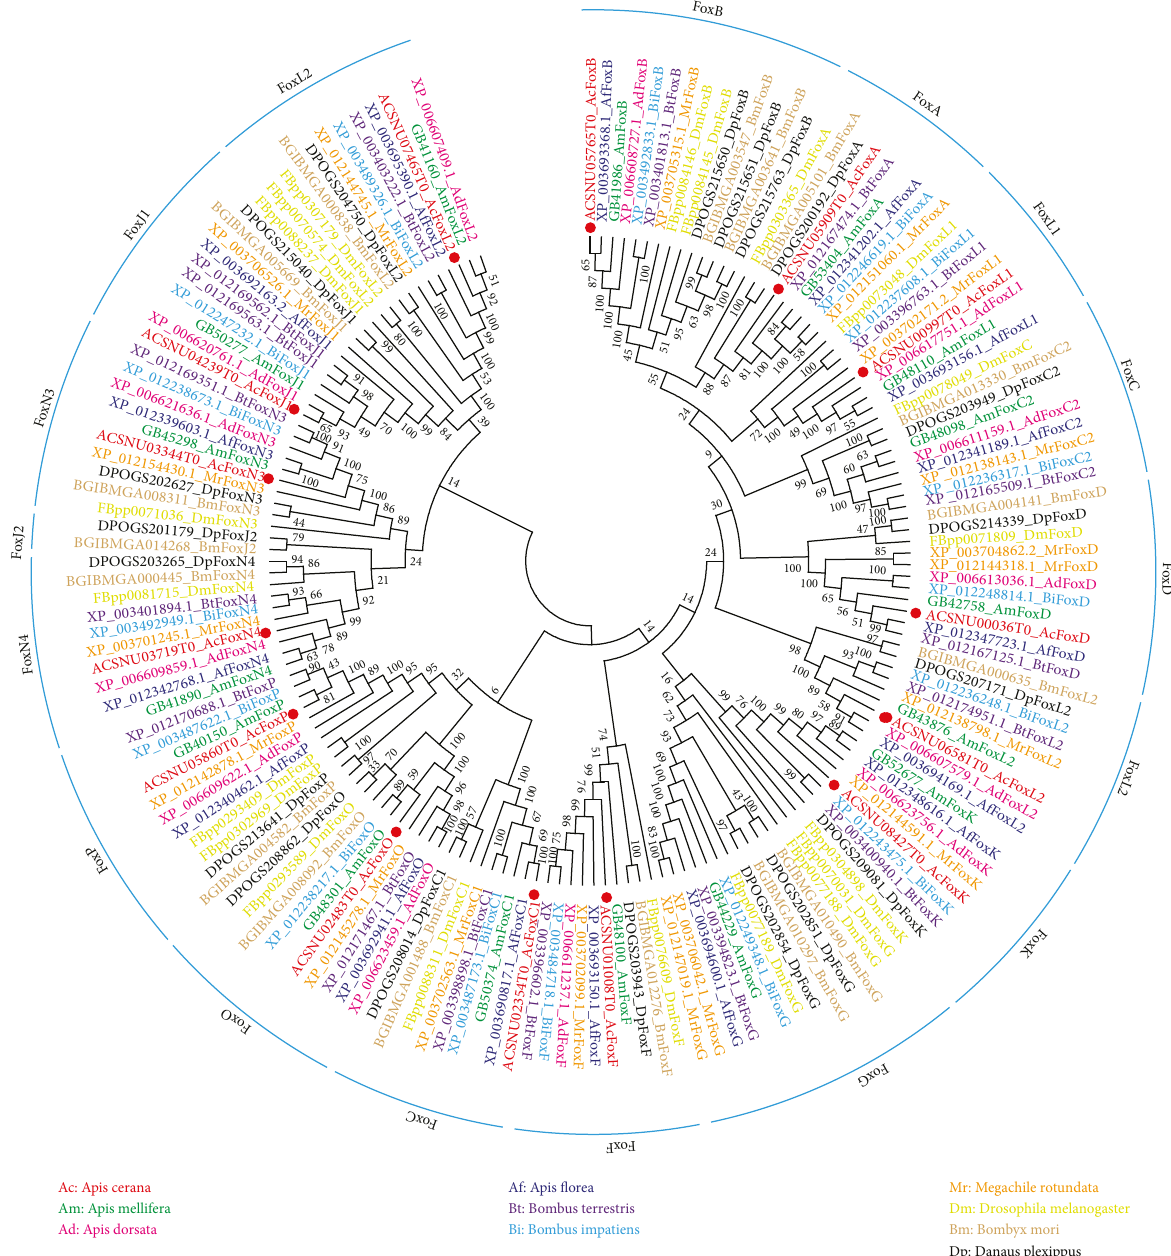
Figure 1: Phylogenetic tree of Fox including the 7 bee species considered in this work (A. cerana , A. mellifera , A. dorsata , A. fl orea , B. terrestris , B. impatiens , and M. rotundata) and the 3 other insect species used as reference (B. mori , D. melanogaster , and D. plexippus) . Colors represent di ff erent species. Red dots indicate A. cerana Fox genes. Protein sequences and accession numbers are provided in Supplemental File